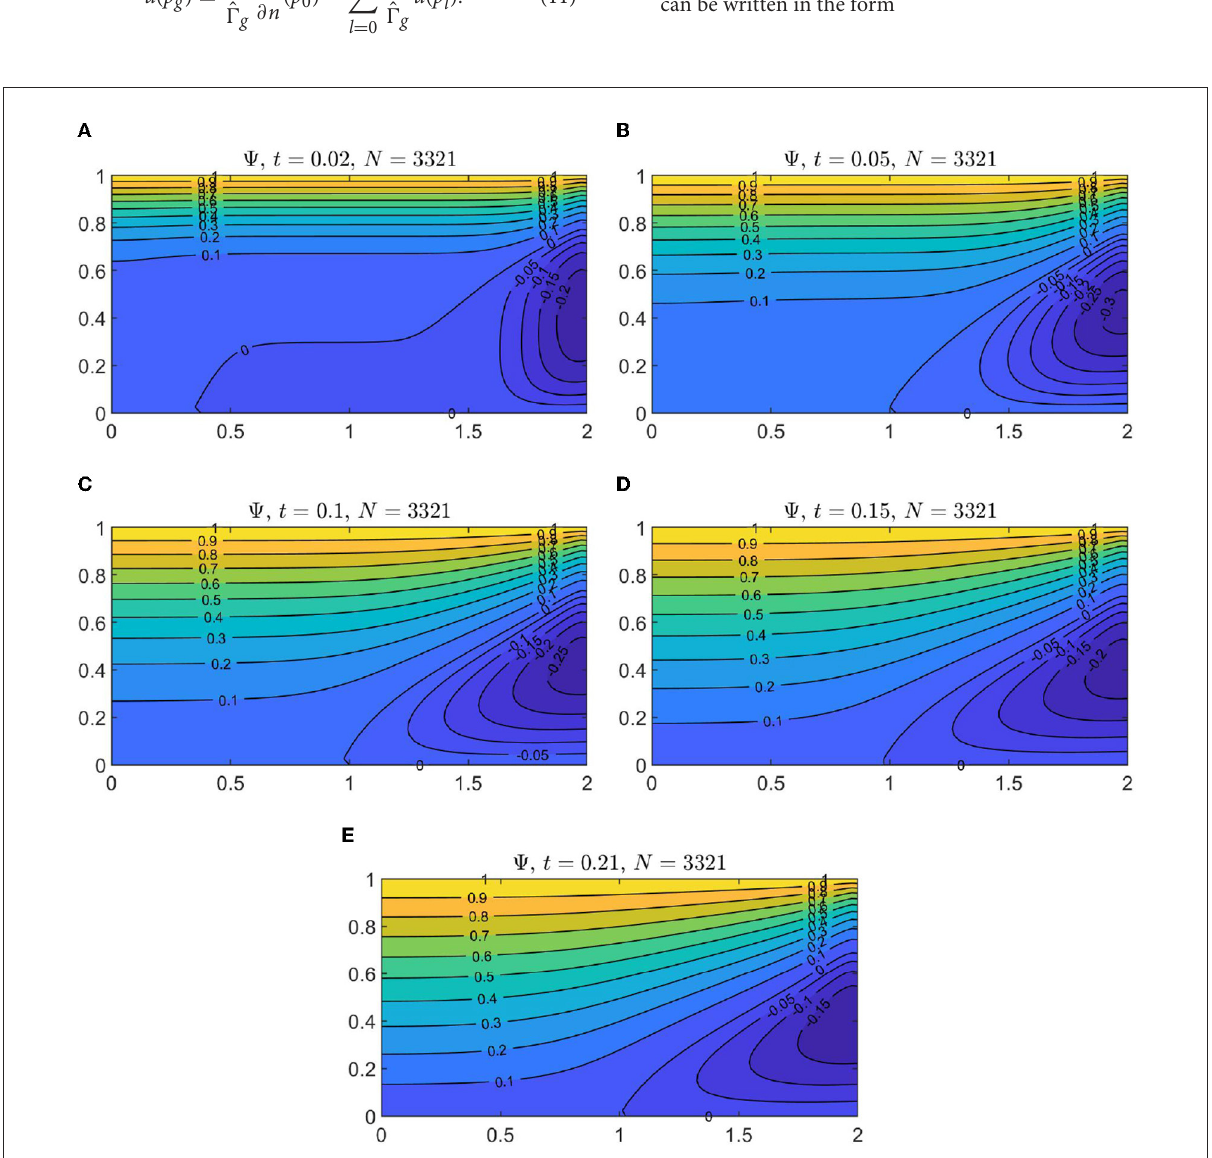
FIGURE6 Streamlines distribution at different time for the original Henry problem. (A) t = 0.02, (B) t = 0.05, (C) t = 0.10, (D) t = 0.15, (E) steady-state t = 0.21 ( a = 0.2637, b = 0.1, N = 81 × 41 =